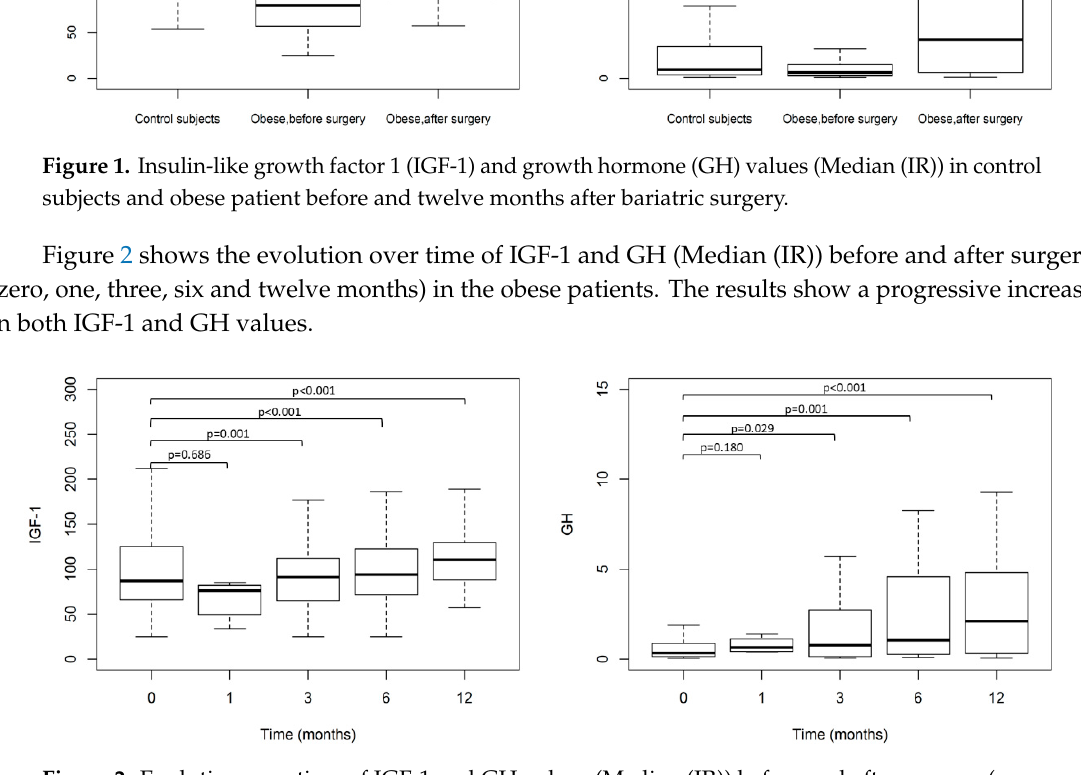
Figure 2. Evolution over time of IGF-1 and GH values (Median (IR)) before and after surgery ( zero, one, three, six and twelve months ).